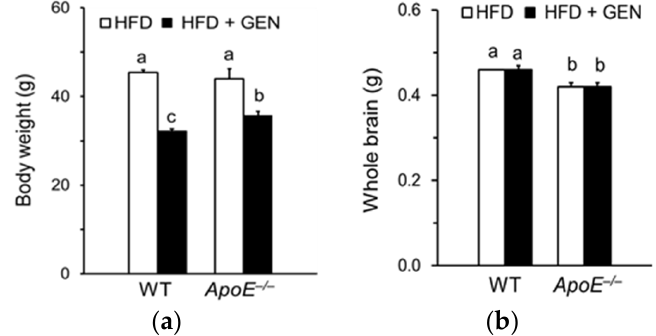
Figure 1. Effects of genistein on ( a ) body weight and ( b ) brain weight of wild ‐ type (WT) and apolipoprotein E knockout ( ApoE − / − ) mice fed a high ‐ fat diet (HFD). Each bar represents the mean ± standard error of the mean (SEM) ( n = 9, 10) and bars with different superscripts are significantly different at p < 0.05.